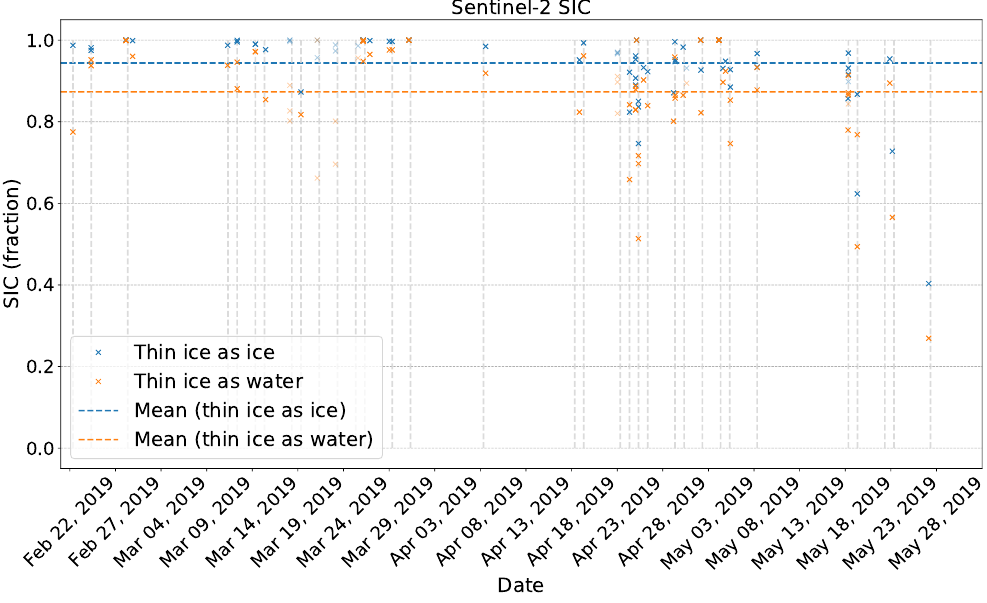
Figure 7. Time-series of the mean thin-ice and thick-ice SIC of all Sentinel-2 scenes. The x-axis shows the date, and the vertical lines mark the days with Sentinel-2 scenes. Scenes which are not used for intercomparison with the other SIC datasets because of the time lag exceeding 120 min are indicated by faint